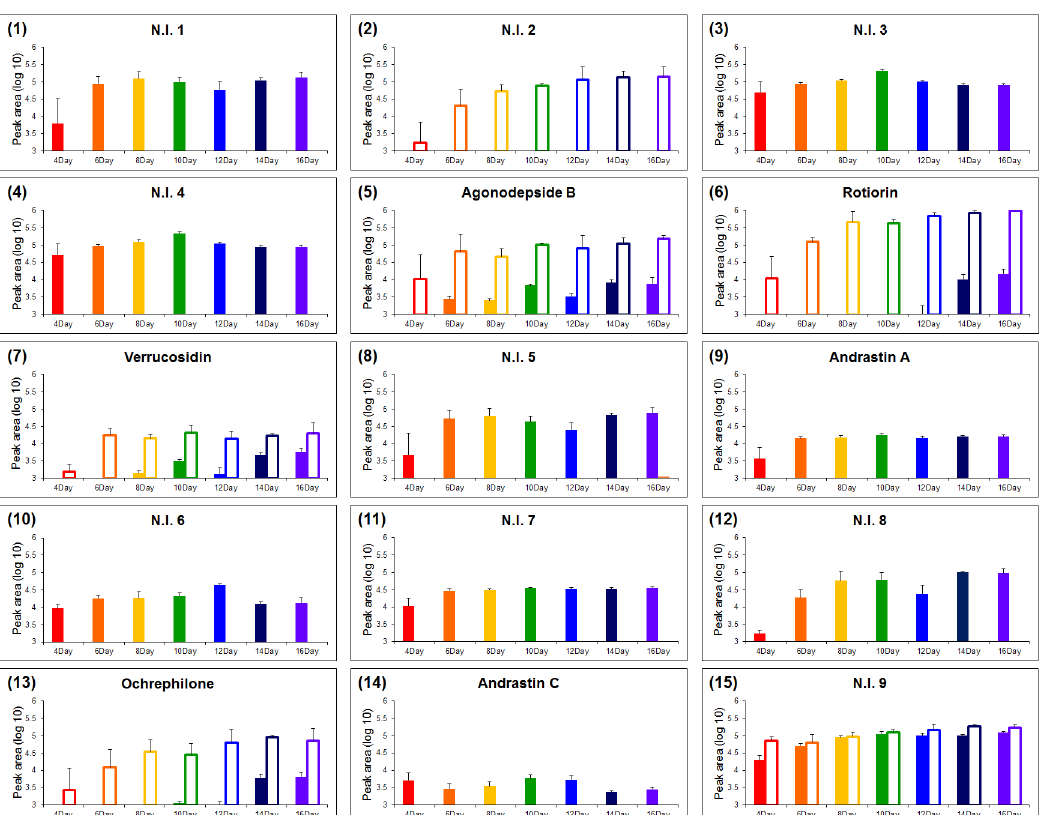
Fig 3. Production profiles of variant metabolites from solid-state and submerged fermentation of P . expansum 40815. The Y-axis of graphs indicates the UPLC-Q-TOF-MS data transformed by log10. ( 4 : Submerged fermentation, ▲ : Solid-state fermentation; red: 4 days, orange: 6 days, yellow: 8 days, green: 10 days, blue: 12 days, navy: 14 days, violet: 16